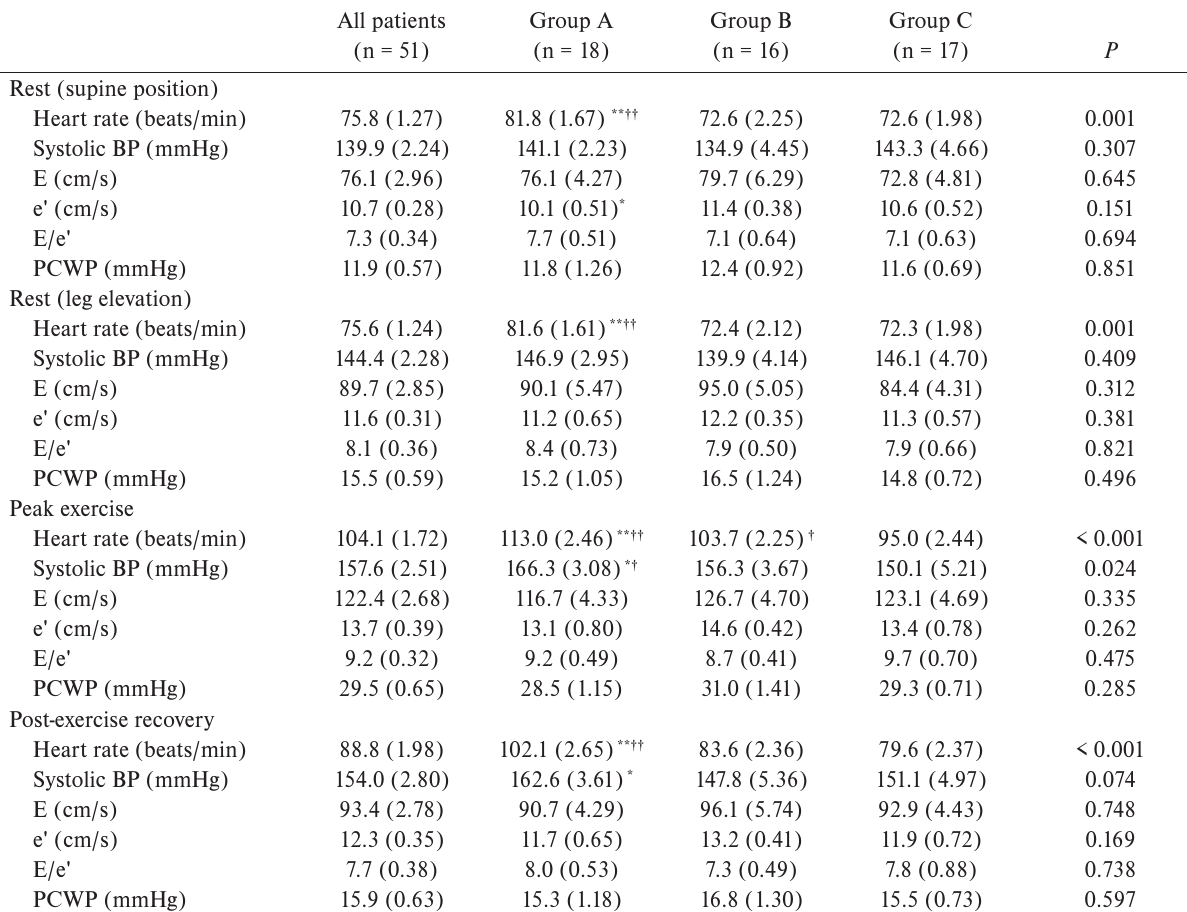
Table 2. Doppler, hemodynamic, and pulmonary capillary wedge pressure data of all patients and those grouped according to post-exercise pulmonary capillary wedge pressure recovery.